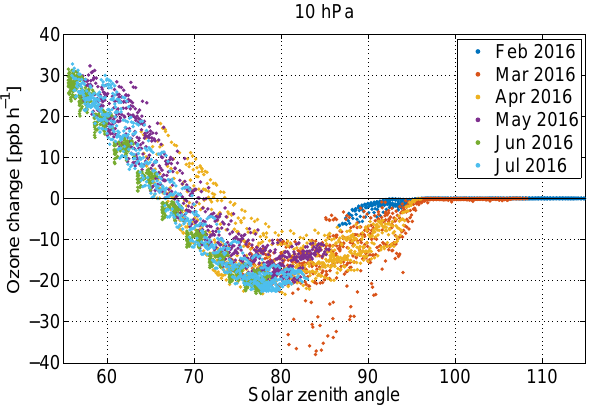
Figure 15. Net chemical ozone change as a function of the SZA modelled by SD-WACCM for Ny-Ålesund at 10hPa for selected month in